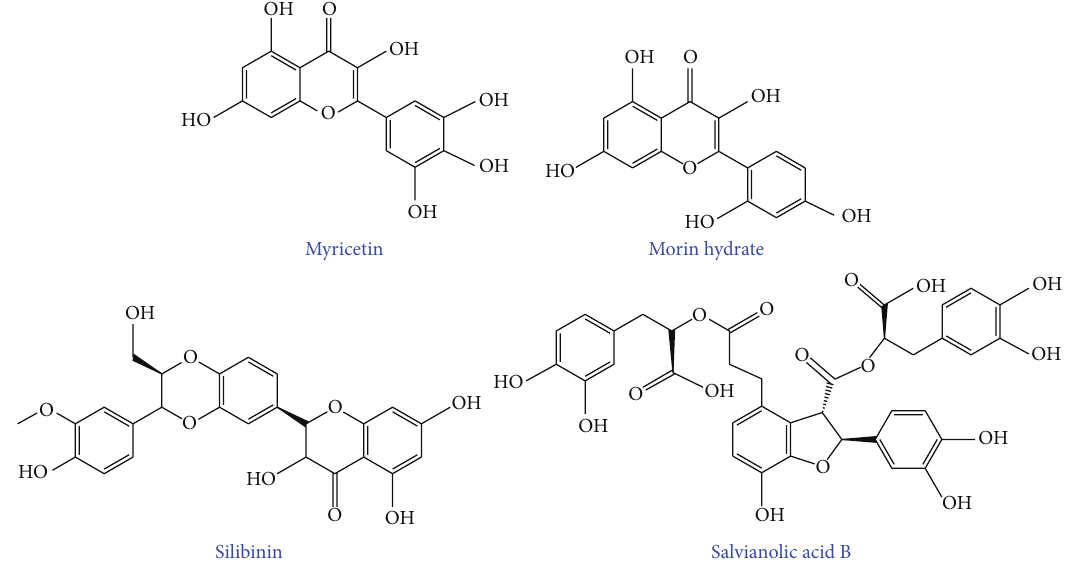
Figure 6: Chemical structures of other polyphenolic small molecule inhibitors of hIAPP